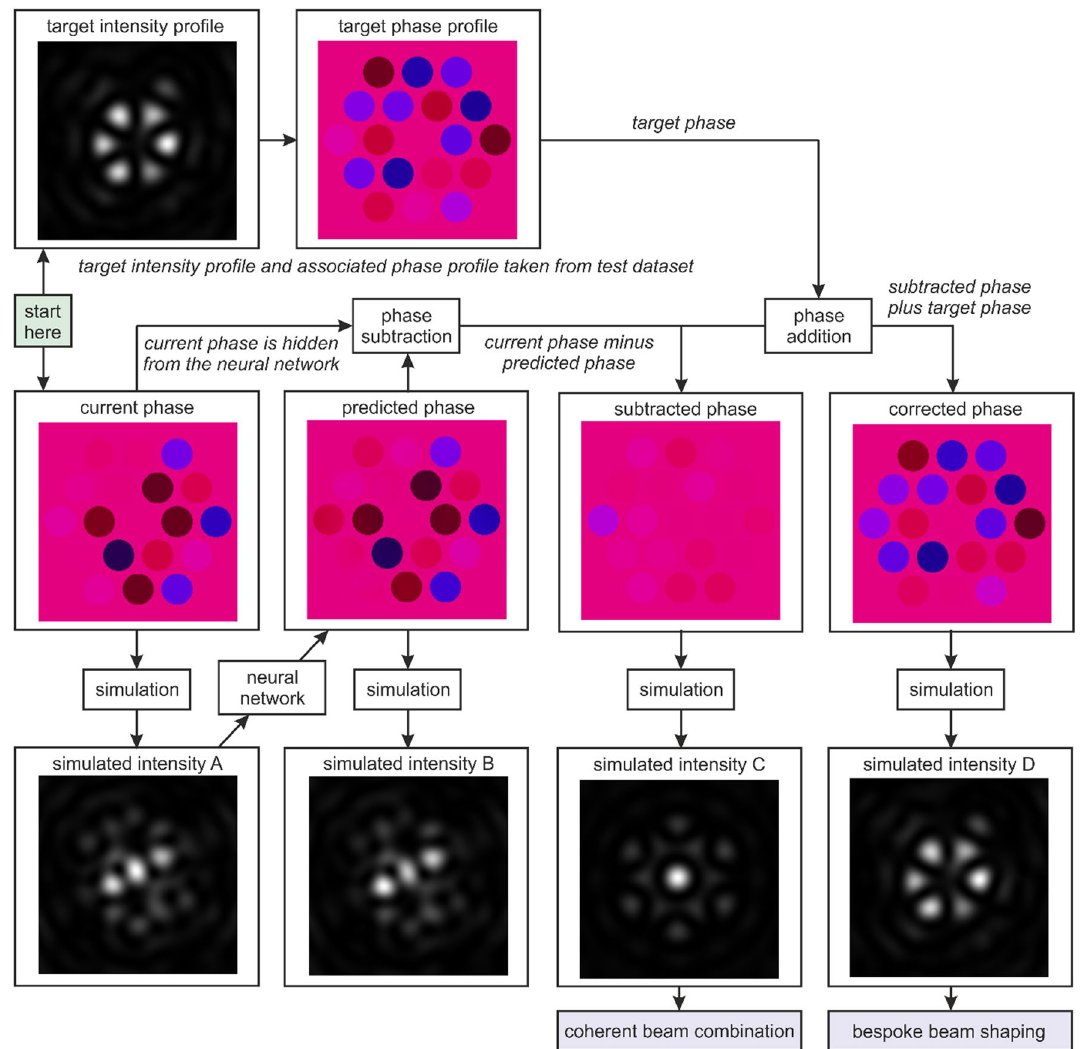
Figure 2. Application of a neural network for bespoke beam shaping for any phase that is unknown to the network. Starting from a current phase (which is unknown to the neural network), the associated simulated intensity is processed by the neural network and the phase is predicted. Subtracting the predicted phase profile from the (hidden) current phase profile produces a flat phase, with error depending on the prediction accuracy. At the same time, the phase profile for a desired intensity profile can be added to the corrected phase, to produce the desired intensity profile. This whole process is possible without knowledge of the current phase and could be completed in a single